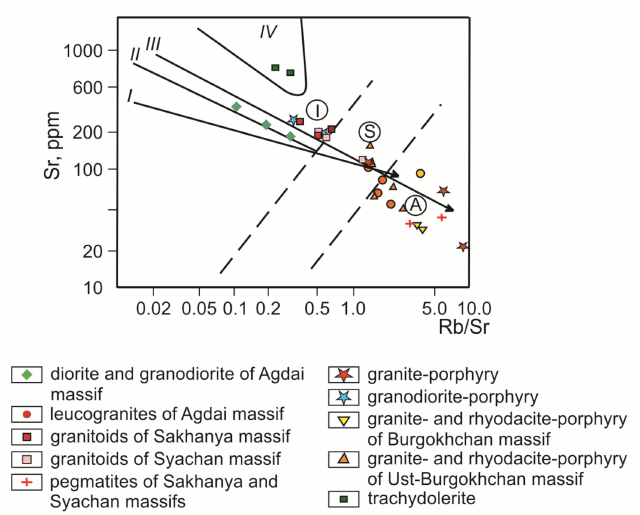
Figure 9. Sr-Rb/Sr ratios in magmatic rocks of the Selennyakh River basin. Trends of differentiation of typical series [43]: I—tholeiitic island arcs, II—calcareous-alkaline island arcs, III—calcareous-alkaline active margins, IV—rift zones of continents; I, S, A—petrotypes of